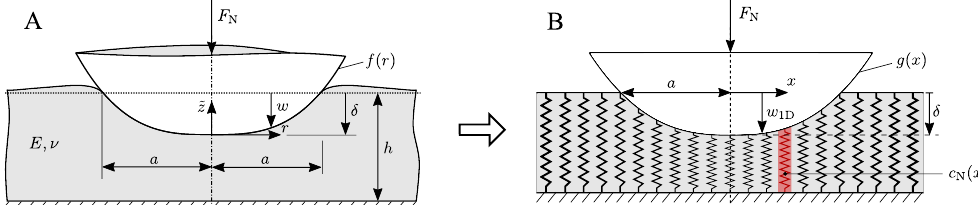
Figure 1. ( A ) Three-dimensional contact problem; ( B ) equivalent one-dimensional contact